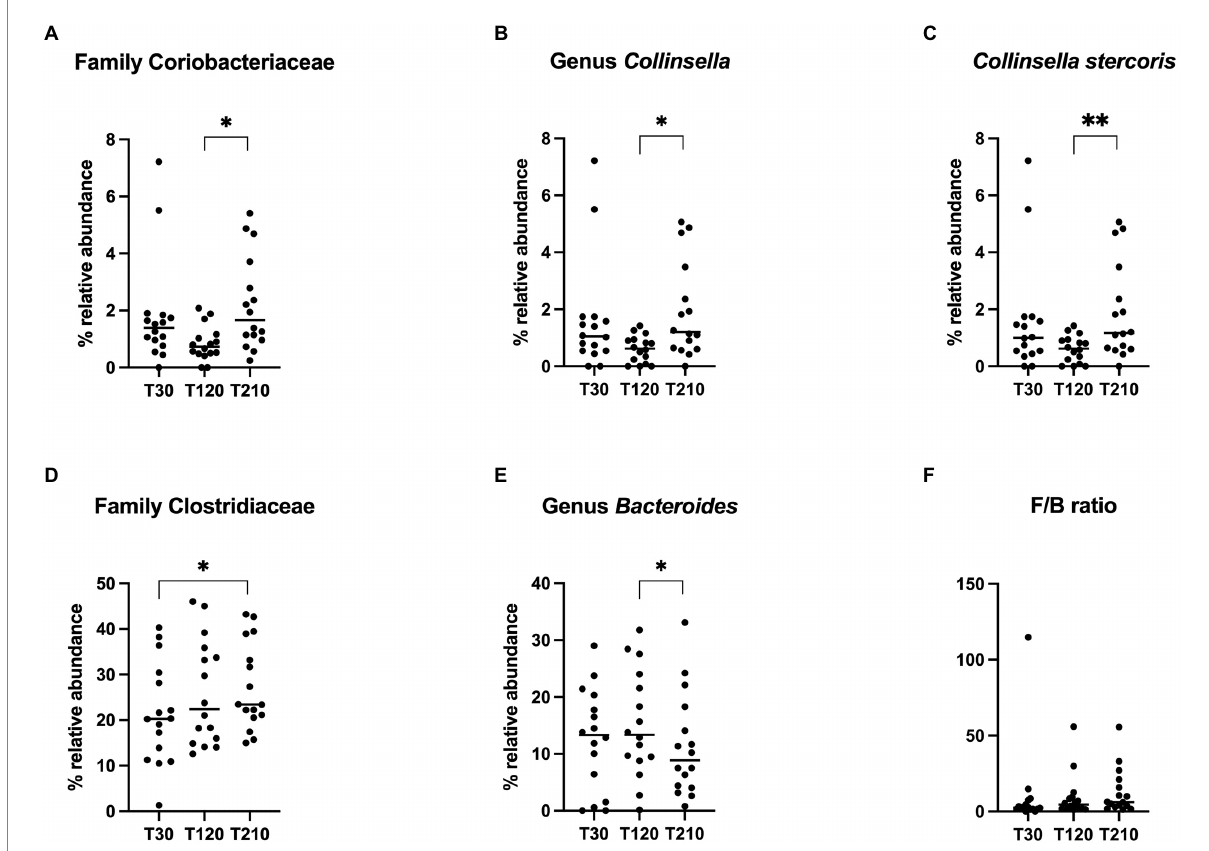
FIGURE 6 Relative abundance of selective bacterial populations: (A) family Coriobacteriaceae, (B) genus Collinsella, (C) species Collinsella stercoris , (D) family Clostridiaceae, (E) genus Bacteroides, (F) Firmicutes/Bacteroidetes ratio, in fecal samples of obese dogs before (T30), after 90 days (T120) and at the end (T210) of caloric restriction. Significance level: * q < 0.05, ** q <